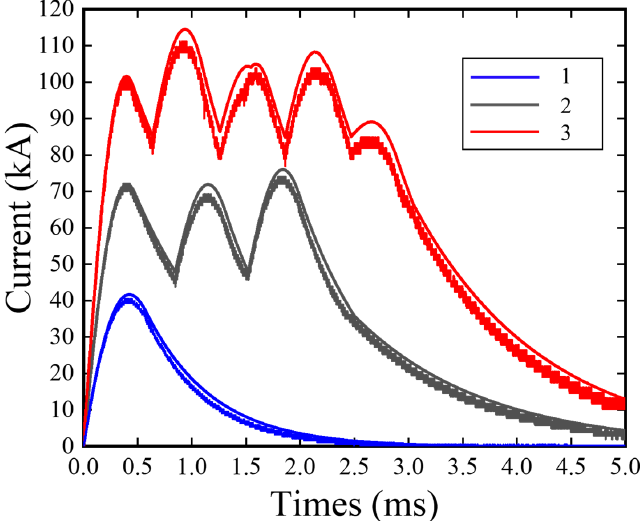
Figure 5. The comparison of the load current between the calculations and experimental result.